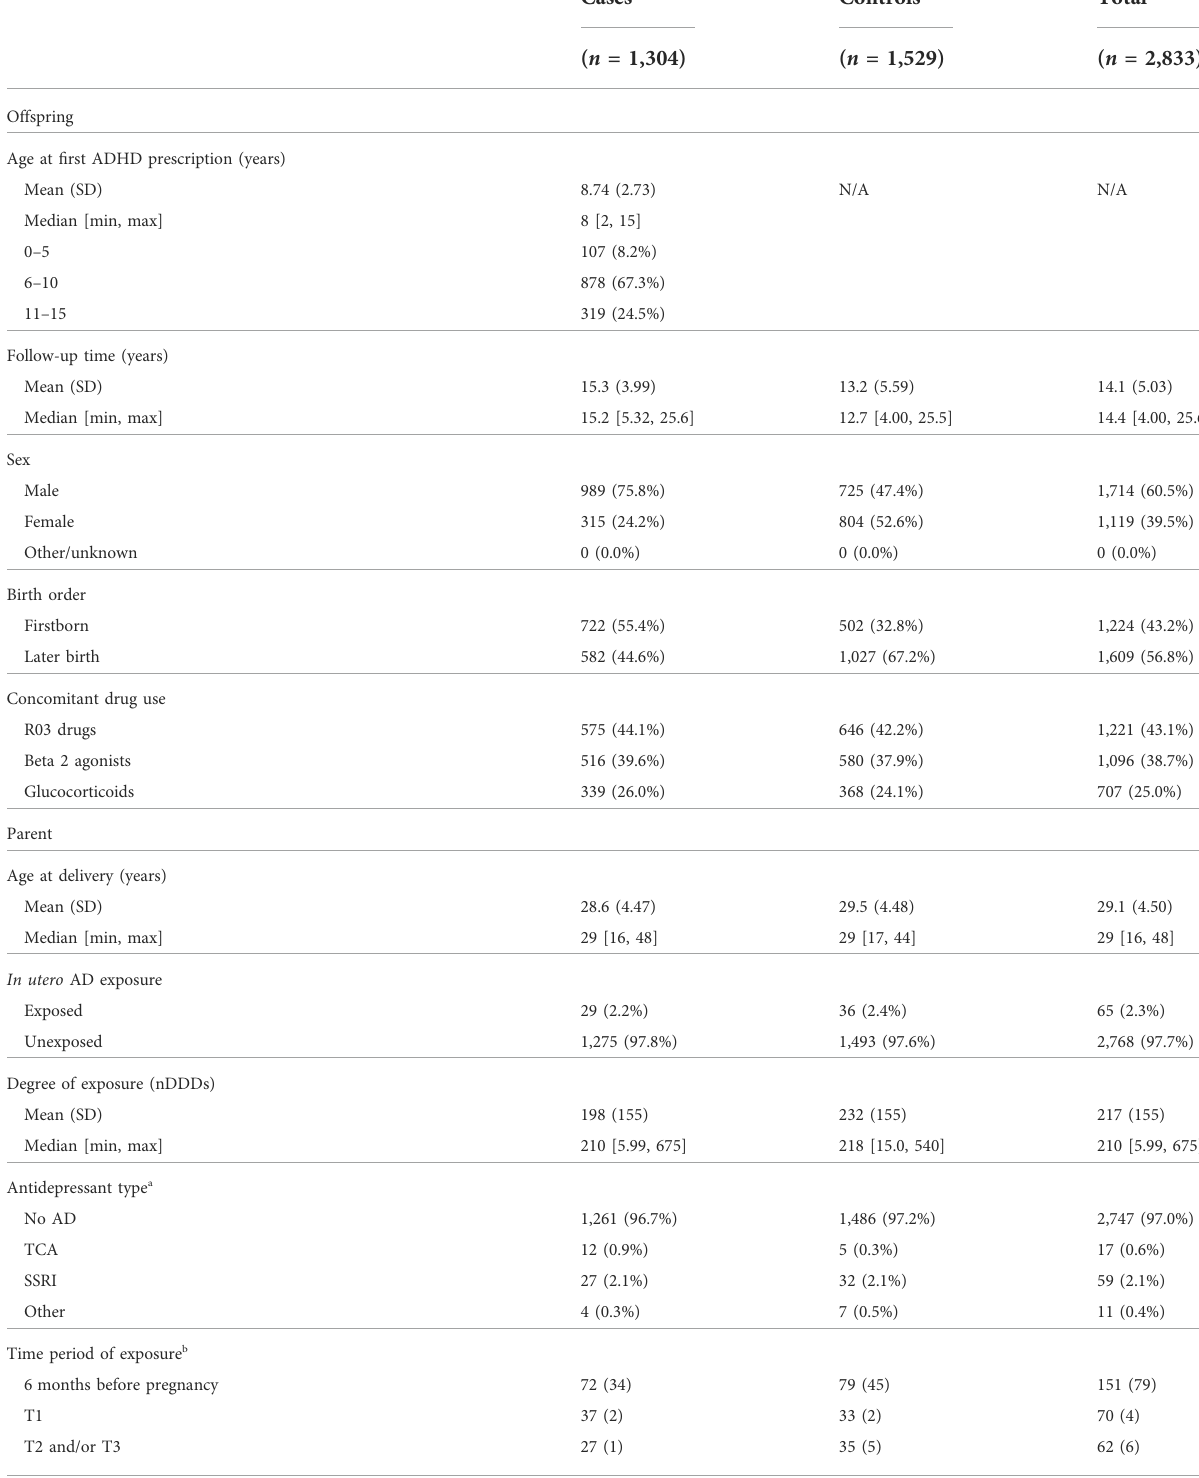
TABLE 1 Baseline characteristics of 2,833 singleton pregnancies in the IADB.nl prescription database, with comparison between cases and controls.